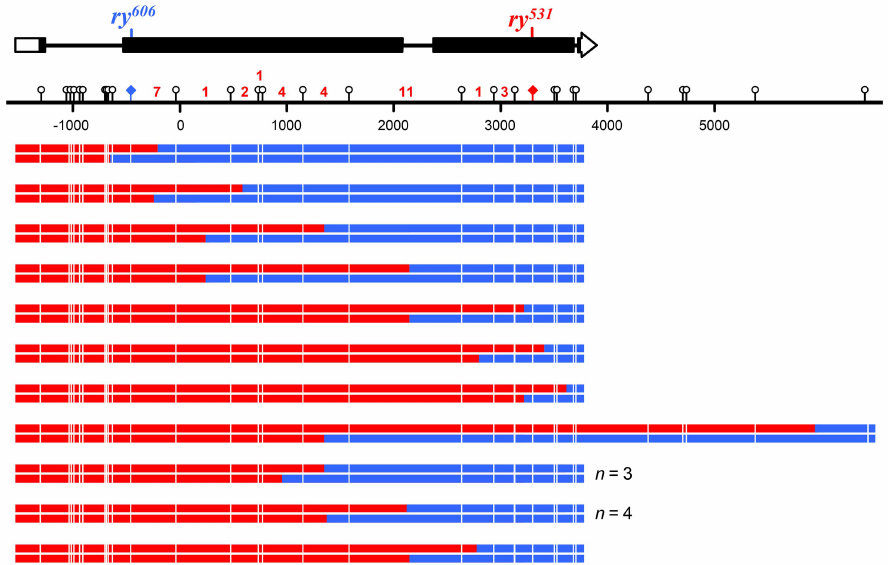
Figure 5. Crossovers from Xpc ; Msh6 mutants. At the top is a schematic of the rosy locus and the location of the mutant alleles used for purine selection (see Figure 3 and Materials and Methods). Each pair of lines below the scale represents the two strands of an independent crossover chromosome (red, sequence from ry 531 chromosome; blue, sequence from ry 606 chromosome). Markers used to map hDNA tracts are indicated with lollipops on the scale bar and white lines on the recombinants. Tract ends are shown as the halfway point between the last marker included in the tract and the first marker not included in the tract. All crossovers with detectable hDNA are shown. The number of crossovers without detectable hDNA that occurred within each interval are indicated in red numbers above the scale bar.